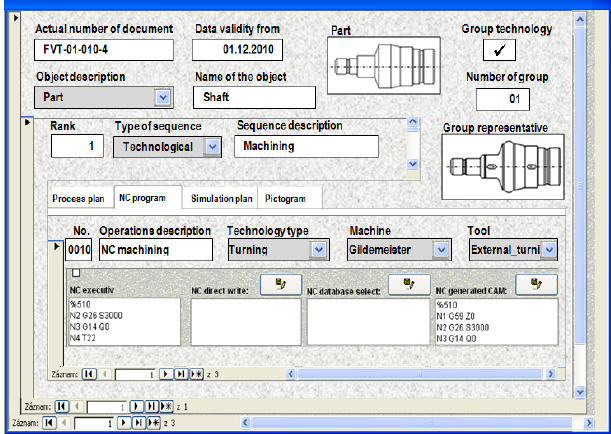
Figure 6. Environment Software application for NC program